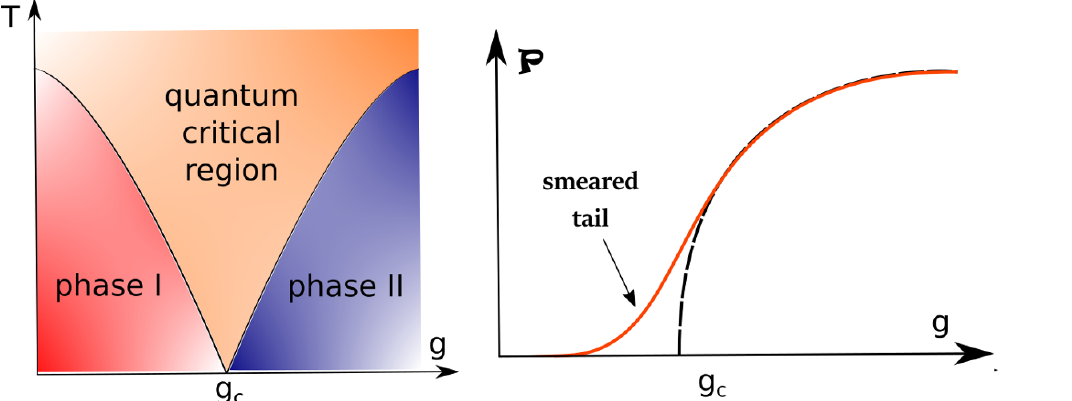
Figure 1 . Left: sketch of the phase diagram as a function of the temperature T and the external non-thermal parameter g . The quantum phase transition between the two phases happens at g (cid:17) g c and T = 0 but it a(cid:11)ects the physics of the system on a larger region extending towards the (cid:12)nite temperature regime, i.e. the QCR (orange area). Right: the evolution of the order parameter P across the quantum phase transition at T = 0. The black dashed line is the clean case where the QPT is sharp while the orange line is the smeared disordered